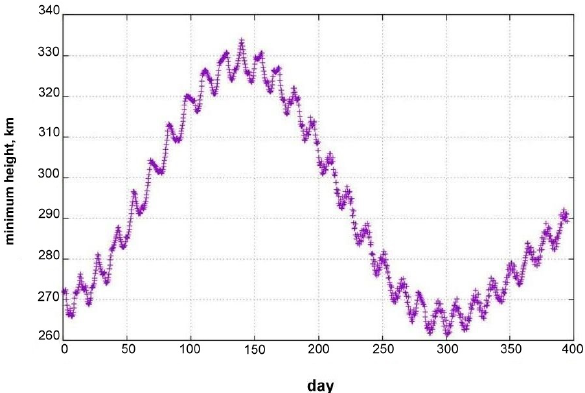
Figure 6. Minimum height for 91689 object.